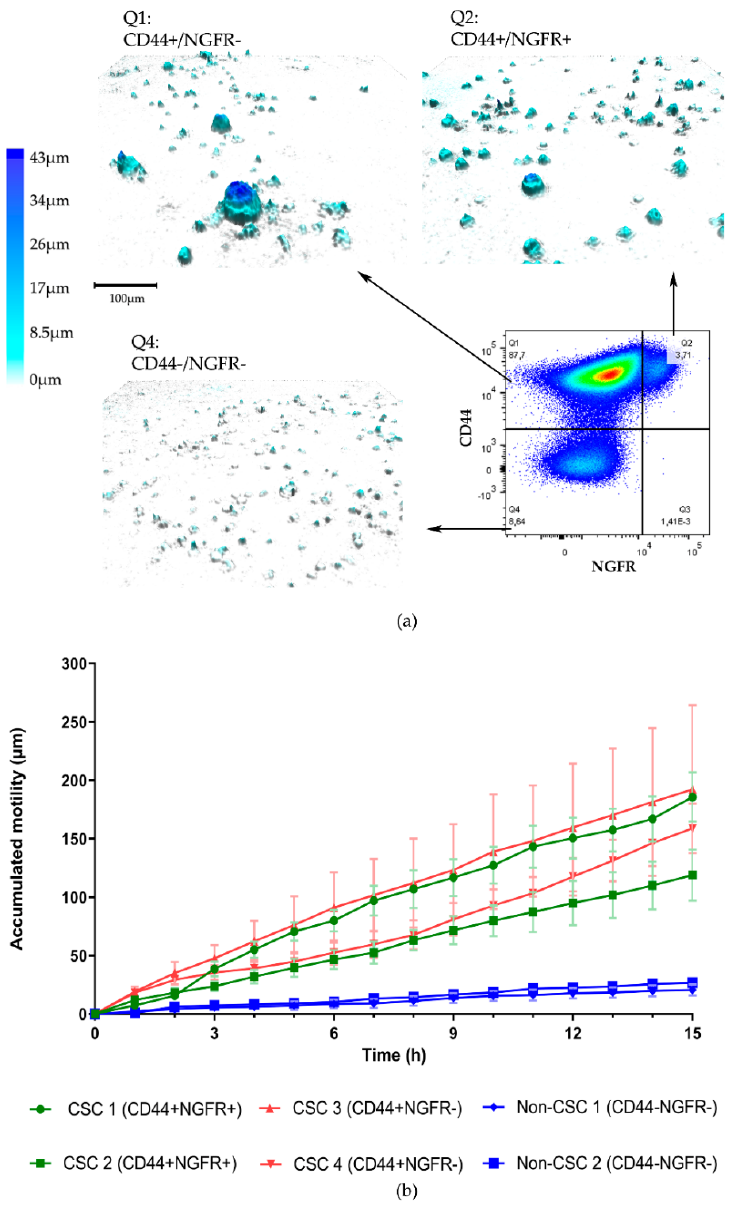
Figure 3. Organoid-formation ability and motility of different oropharyngeal squamous cell carcinoma-cell phenotypes. ( a ) Cells derived from quadrants Q1 and Q2 included cancer-stem-cell (CSC) phenotypes CD44 + /NGFR − (Q1) and CD44 + /NGFR + (Q2). Q4 contained the CD44 − /NGFR − nonstem-cancer-cell population. DHM images obtained for each cell phenotype (Q1, Q2, and Q4) at t = 15 h. ( b ) Average accumulated motility of single cells according to expression of CD44 and NGFR. Five single cells were monitored for each phenotype in duplicates.